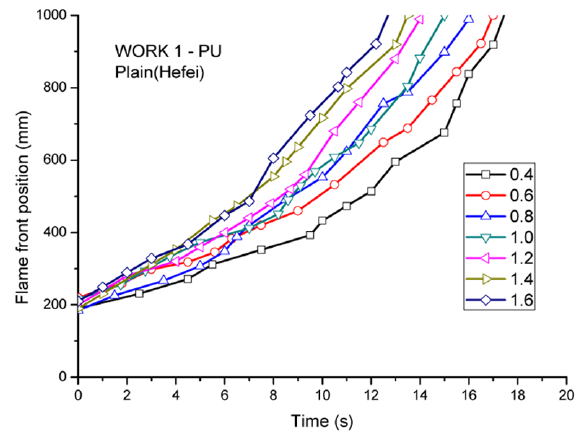
Fig. 10. Flame front position results from WORK 1